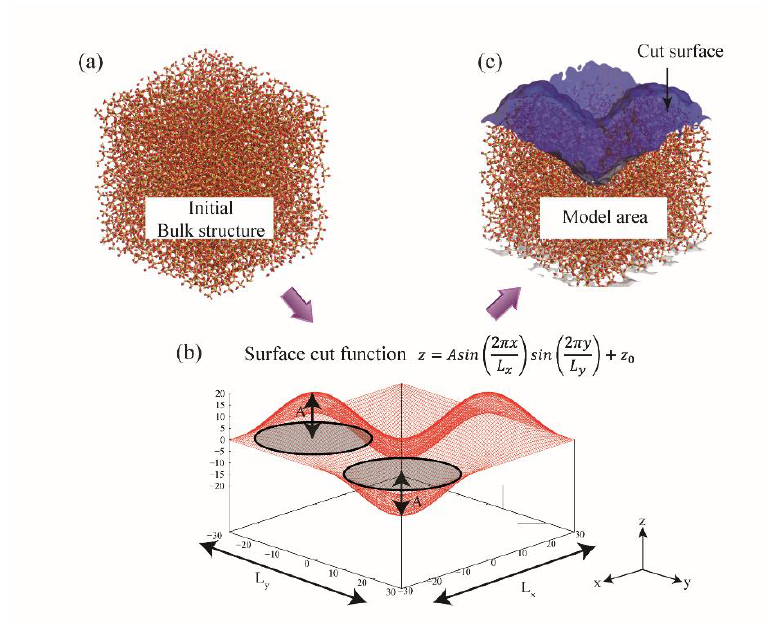
Figure 2 . Schematic procedure of generating rough surface. ( a ) Initial bulk glassy silica. ( b ) Prede- fined surface with sine function, z = A sin 2 π x blue shaded area represents cut surface by the sine (adapted with permission from Reference [31], Copyright 2017 American Chemical Society).